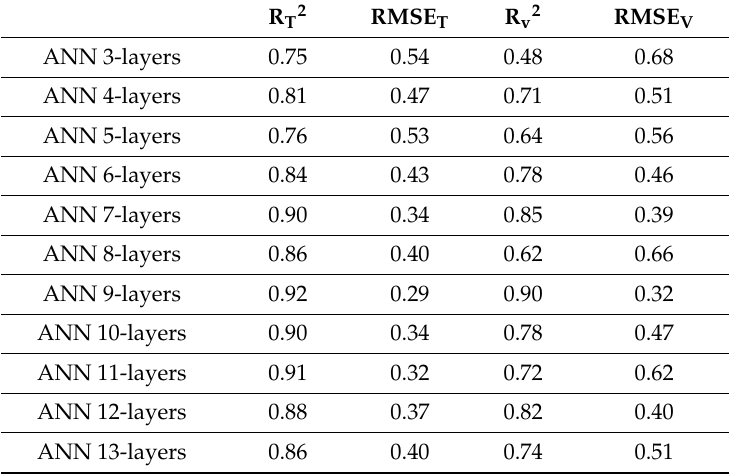
Table 3. Predictive and extrapolation powers of the QSAR models derived by ANN